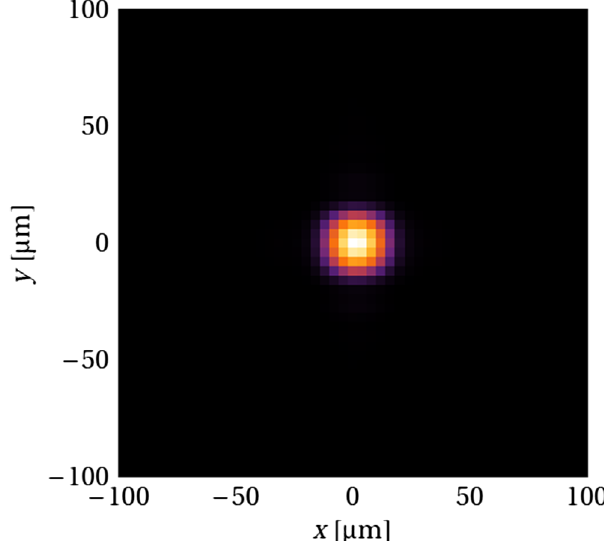
FIG. 8. Plot of XFELO pulse power vs turn number from numerical simulation. Maximum power of 15 MW is achieved at turn 95. The inset shows the frequency spectrum at peak power. The spectrum has a full-width half-maximum (FWHM) of 2 meV corresponding to a relative bandwidth of 1 . 4 × 10 − 7 .